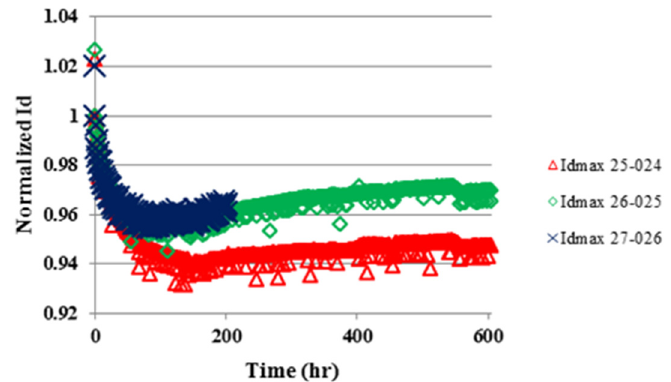
Figure 5. Normalized values (to the 1 h, 245 °C measurements) of I Dmax over time during the 600 h test.